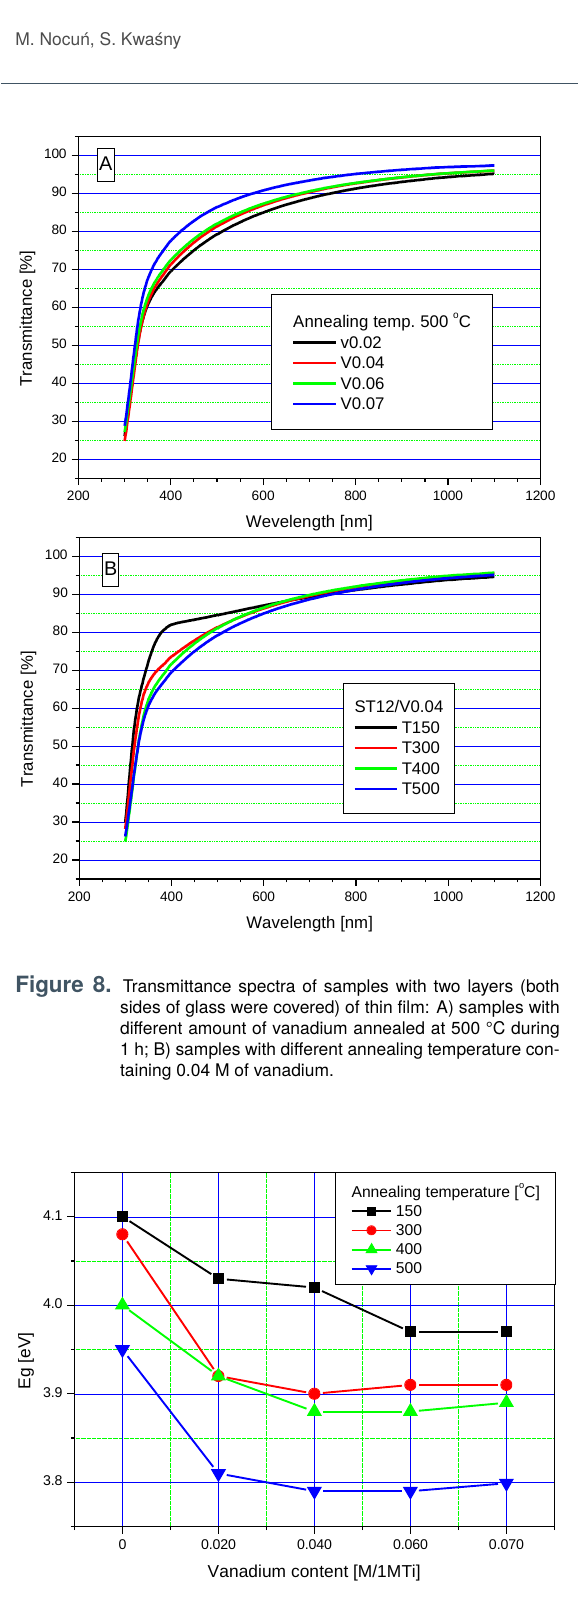
Figure 9. Optical band gap energy of SiO 2 /TiO 2 thin films as a func- tion of vanadium content and annealing Fig.9. Optical band gap energy of SiO 2 /TiO 2 thin films as a function of vanadium content and annealing temperature